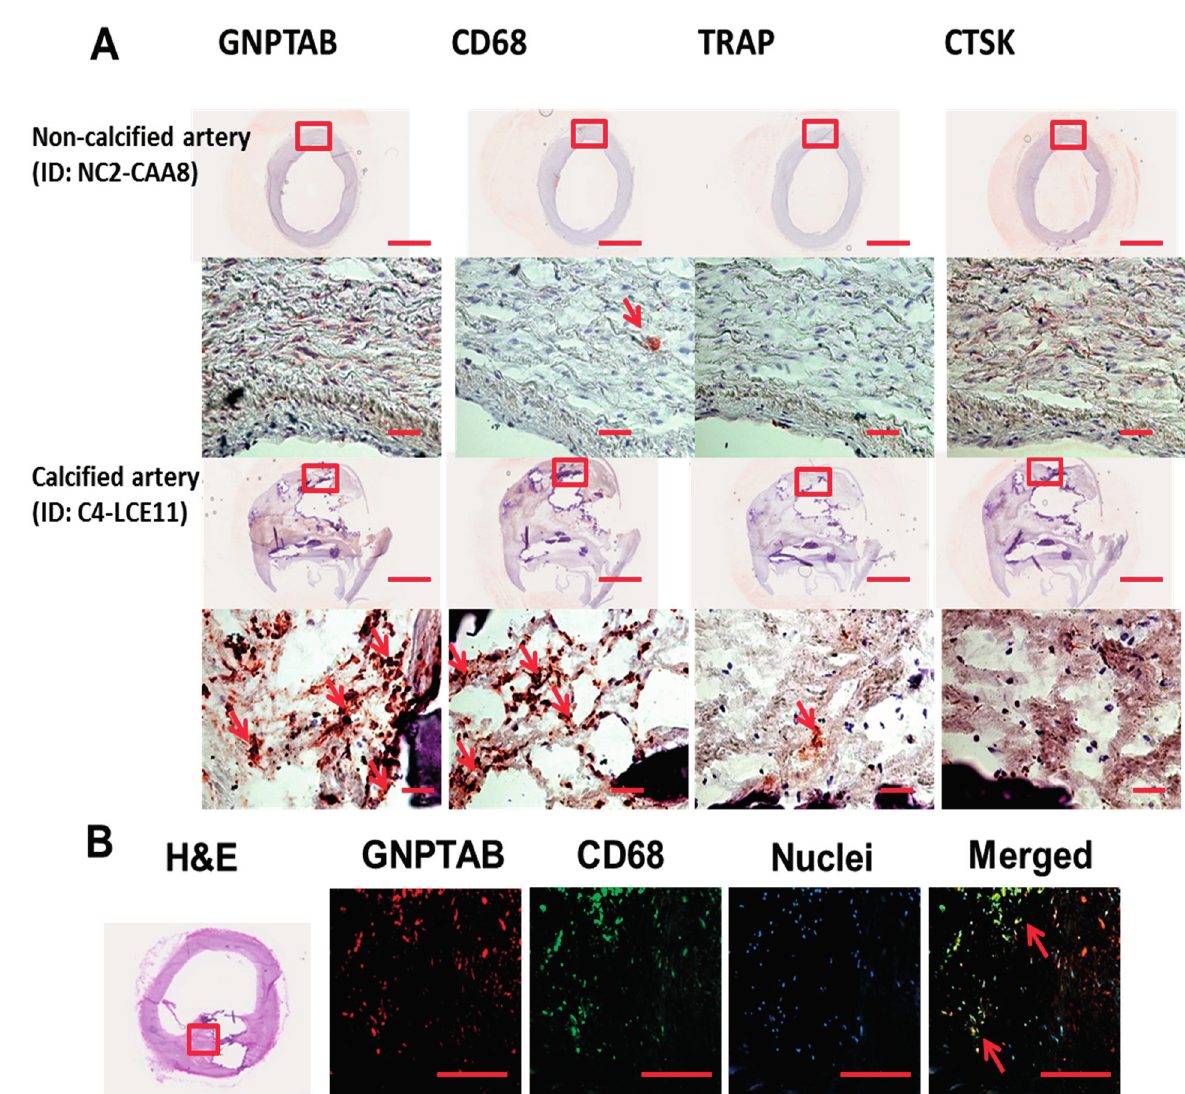
but low expression of TRAP and CTSK in calcified arteries. No GNPTAB expression was observed in non-calcified arteries. Top row: bar = 2 mm; bottom row: bar = 500 µm. n = 3: non-calcified arteries; n = 6: calcified arteries; ( B ) Double fluorescence labeling for GNPTAB and CD68 identified a large population of macrophages co-expressing GNPTAB (arrows). Bars = 200